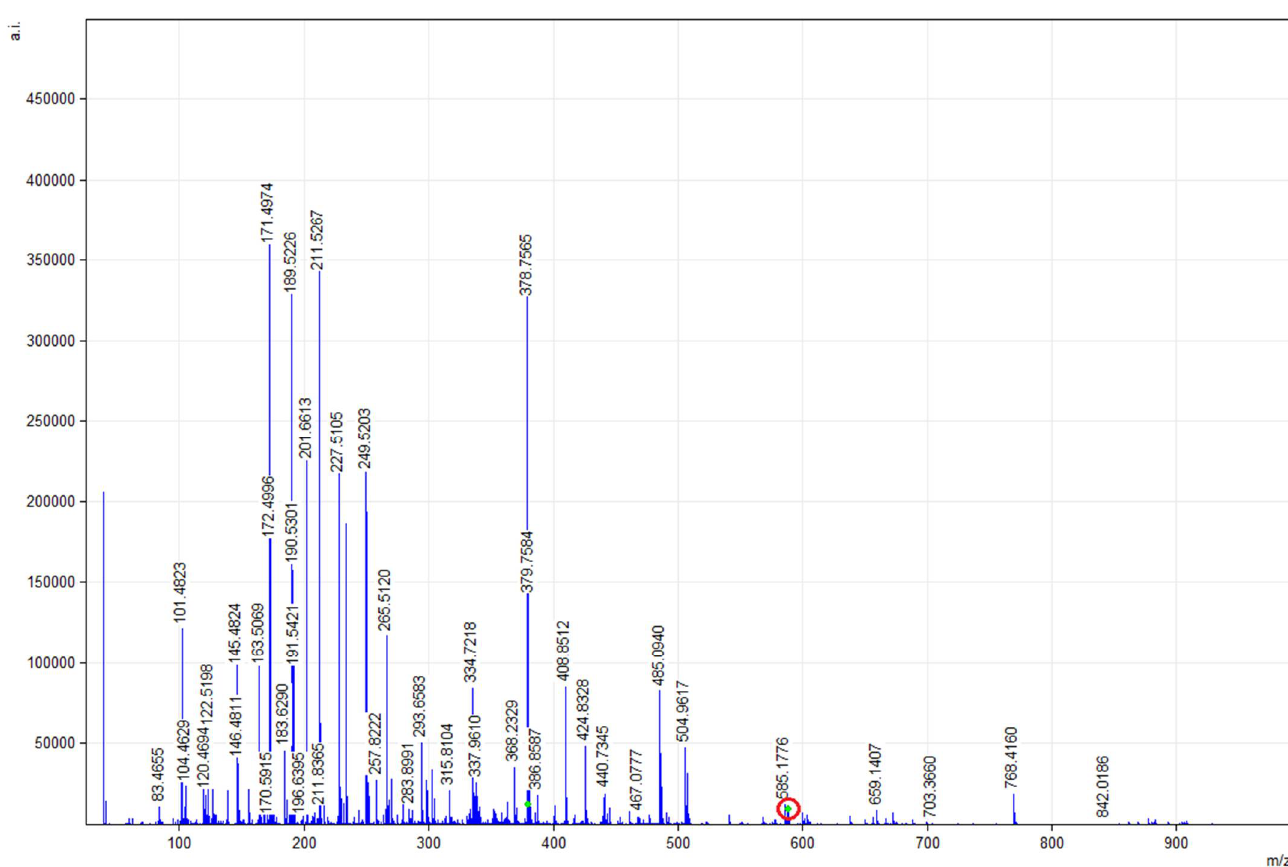
Figure 3. MALDI-TOF mMass report spectrum of glycerolipid (GL) profile resulting from Extraction 1 (30 min). Spectrum obtained between 100 and 900 m / z ratio values from a sample of sAG mixed with the CHCA1 matrix. The m / z ratio signal marked in blue corresponds to DG presenting EPA/DHA at the sn -2 position. Database: LIPID MAPS for glycerolipids.